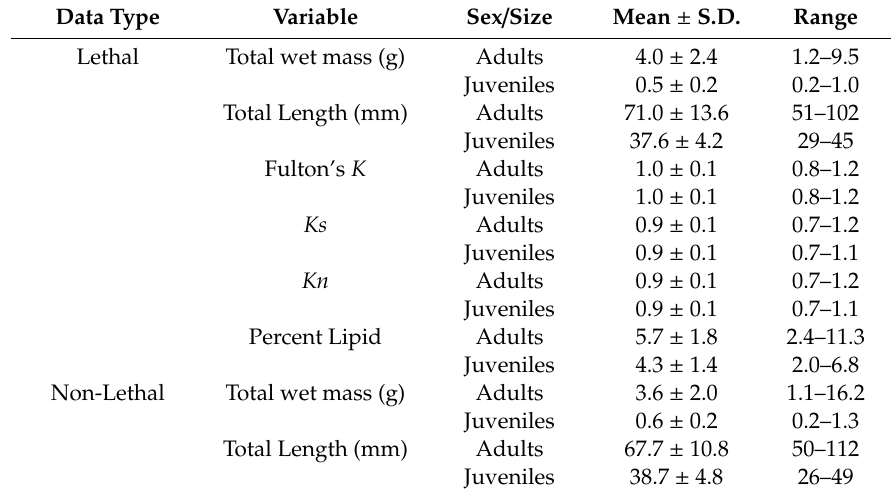
Table 1. Descriptive statistics of the variables used in our analyses. S.D. = standard deviation; Fulton’s K = Fulton’s condition factor; Ks = Fulton’s condition factor excluding stomach content and gonadal mass; Kn = Le Cren’s relative condition factor. n = 68 and 25 for lethally sampled adult and juvenile Cottus cognatus , respectively. n = 937 and 509 for non-lethally sampled adult and juvenile Cottus cognatus ,